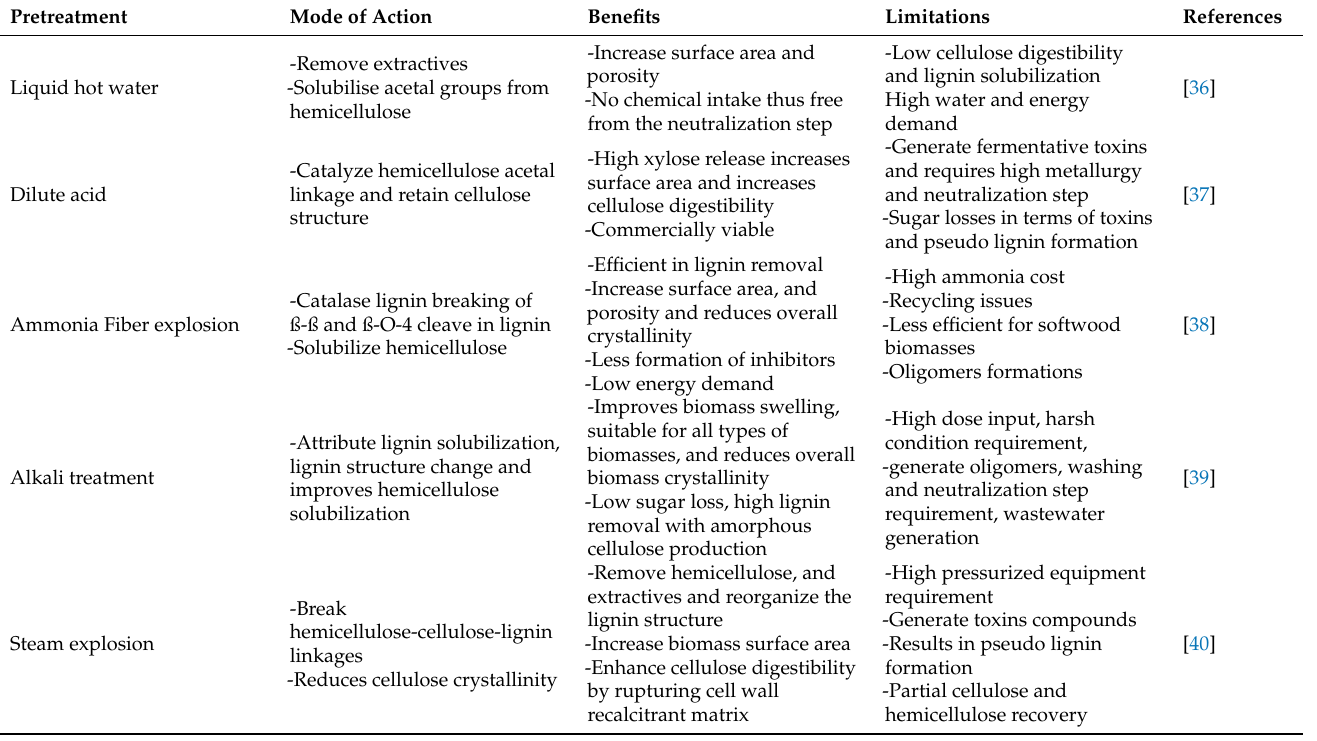
Table 1. Pretreatment type, mode of action on specific cell wall components and their